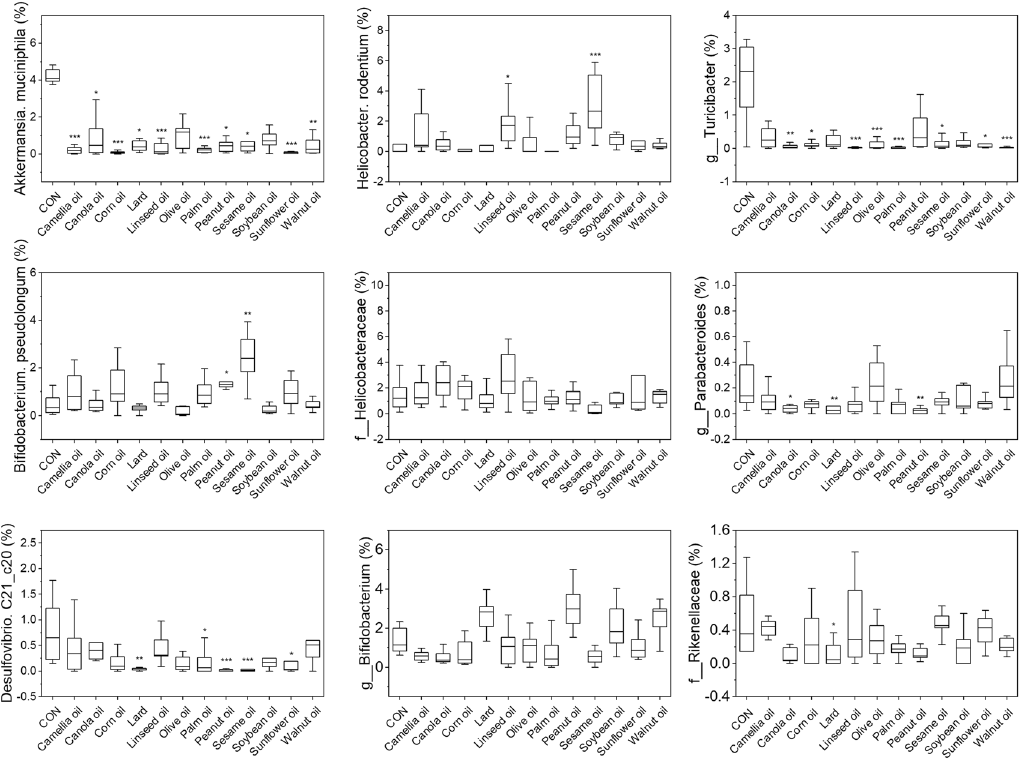
Figure 3. The relative abundance of top 9 importance taxon identified from Random forest analysis in each dietary oil intervention group. All intervention group data were compared with the control group using the Kruskal–Wallis test. *p < 0.05; **p < 0.01; ***p <